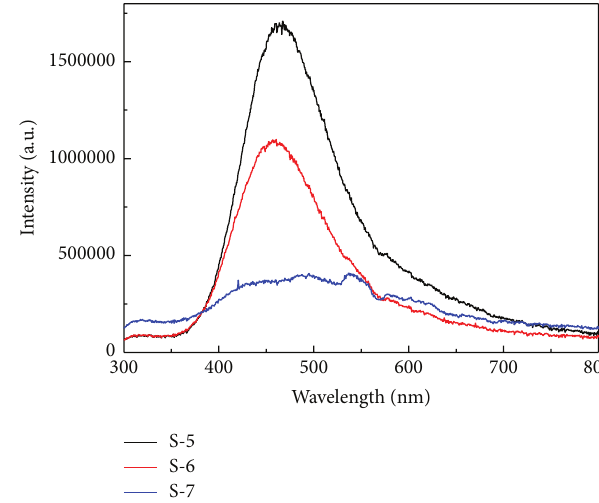
Figure 8: Photoluminescence spectra of the Al-doped CdO thin films surface of S-5, S-6, and S-7